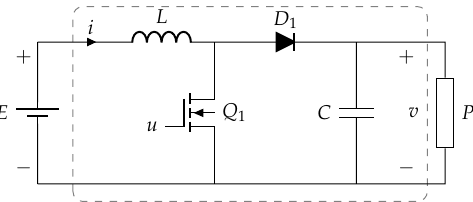
Figure 2. Scheme of a DC–DC boost converter supplying a